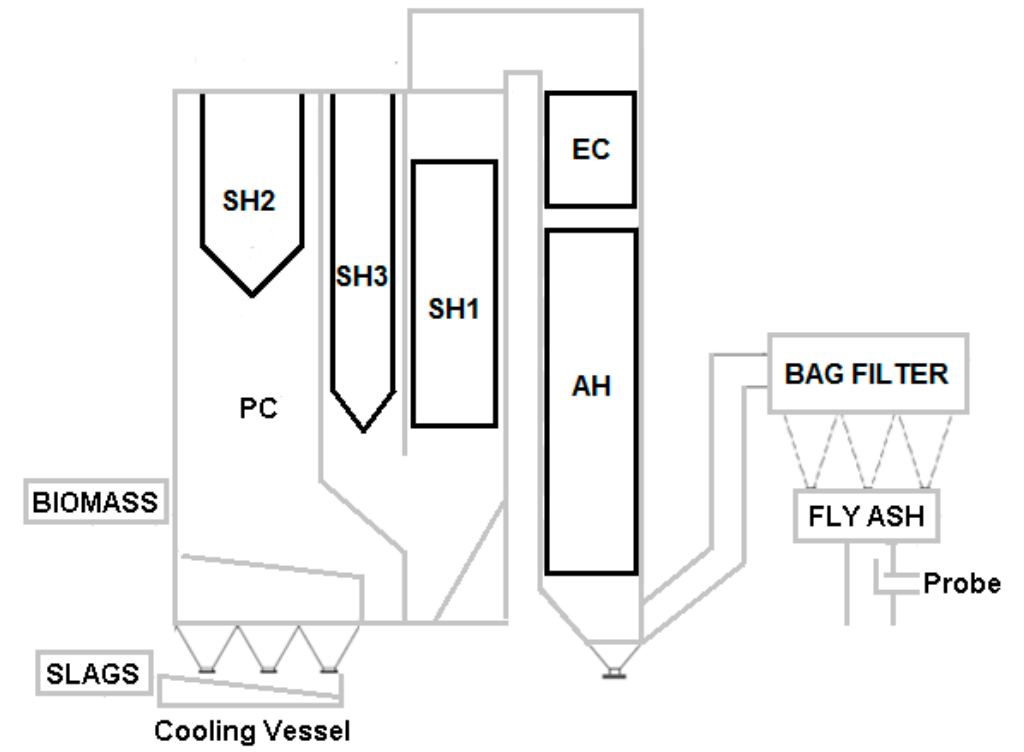
Figure 1. Schematic diagram of the 16 MW th biomass firing power plant owned by Acciona Energía in Briviesca (Burgos, Spain). See the text (previous paragraph) for descriptions of the acronyms.